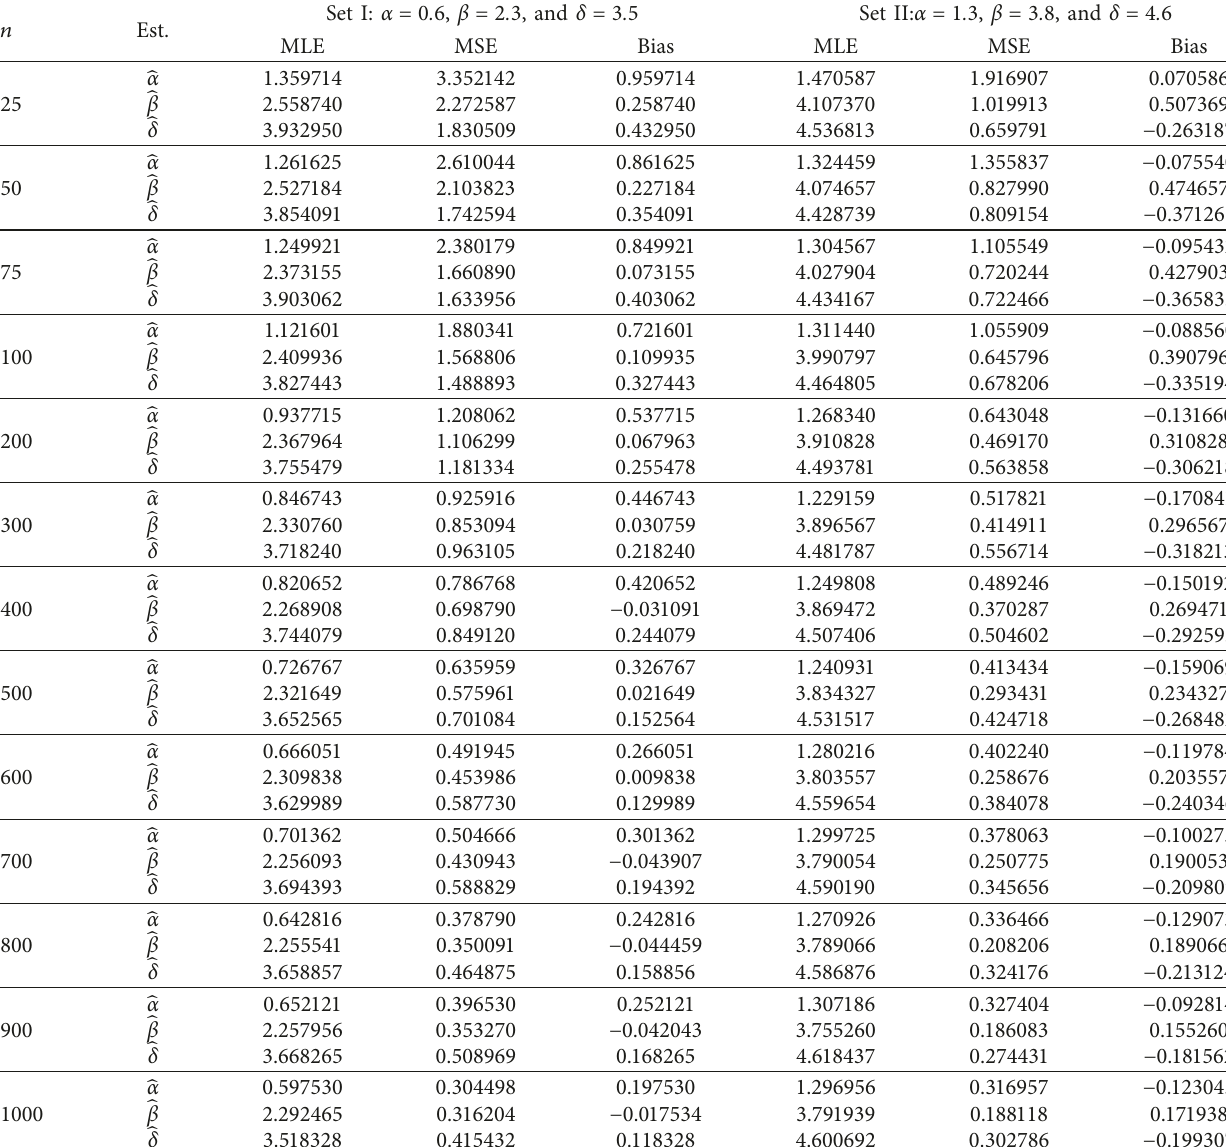
Table 1: The results of conducting a simulation using the NFLog-Wei distribution utilizing sets I and II. n